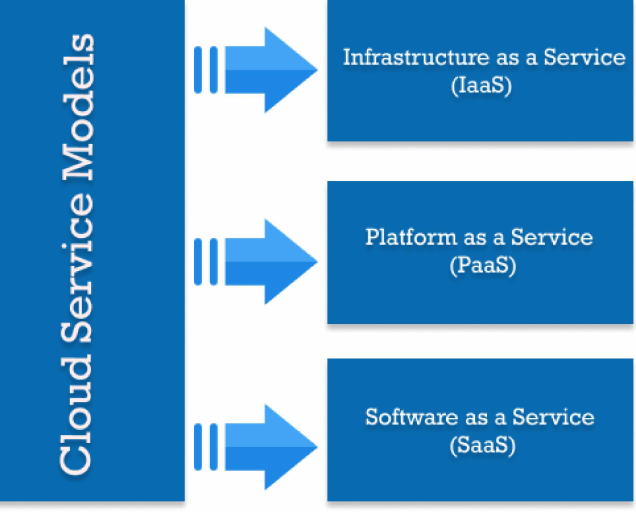
Figure 9. Cloud service models